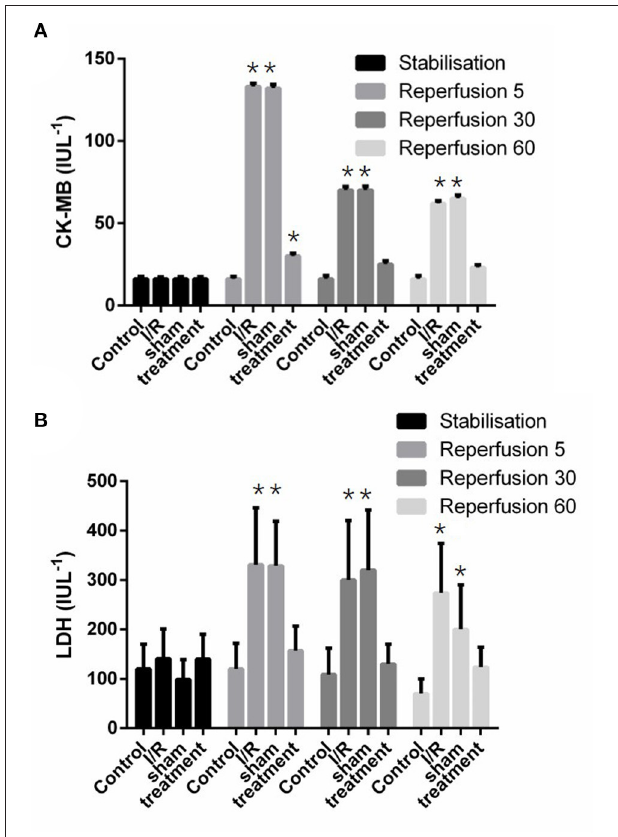
FIGURE 5 | The effect of liver remote ischemic preconditioning on the release of CK-MB (A) and LDH (B) in the isolated rat heart subjected to 30-min global ischemia followed by 90-min reperfusion. Values are expressed as means ± SD obtained from at least six tested mice in each group. * p < 0.001 vs. treatment and sham-operated group. CK-MB, creatine kinase-myocardial band; LDH, lactate